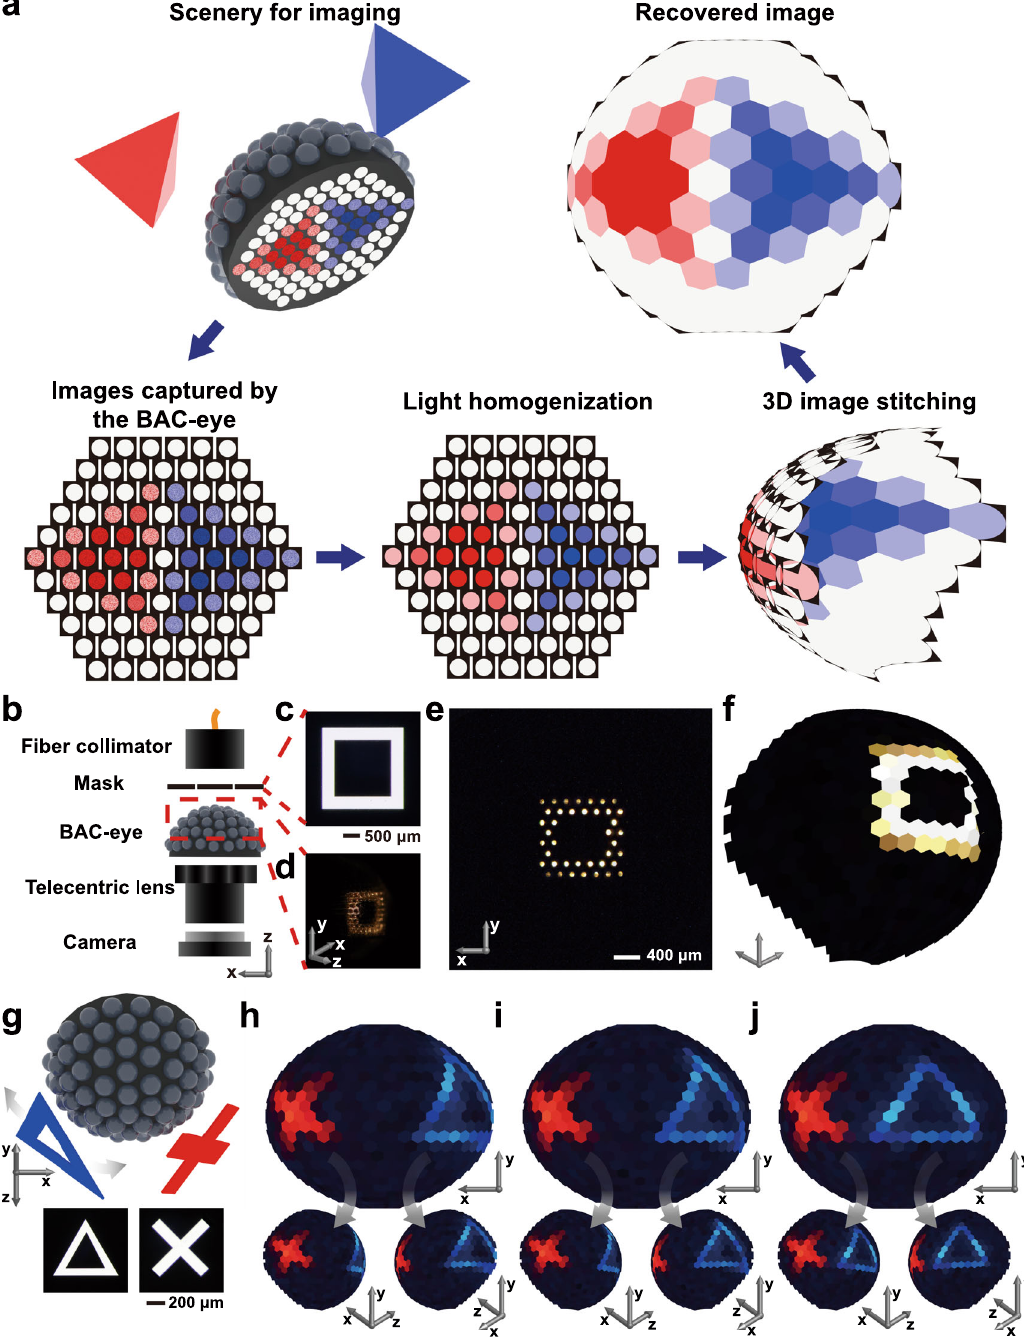
Fig. 4 Imaging using the BAC-eye. a Work fl ow for image acquisition and processing by the BAC-eye. The colour scale represents the intensity level of the detected signals. b Schematic diagram of the experimental setup of the imaging system. c The square mask used for image detection experiments. d The illuminated square pattern as detected by the BAC-eye. The image of the illuminated pattern on the arti fi cial ommatidia is captured by a single-lens re fl ex (SLR) camera equipped with a macro lens. e The square pattern image captured from the bottom of BAC-eye. f The digitally reconstructed hemispherical image. g Illustration of the hemispherical imaging for a red cross pattern whose centre is fi xed at an angular position of ( α = 60°, β = 0°) and a blue triangular pattern moving from the side ( α = 85°, β = 180°) toward the red cross. h – j The reconstructed images showing the triangle as it travels from ( α = 60°, β = 180°), ( α = 40°, β = 180°), and ( α = 20°, β = 180°). The digitally generated callouts provide stereoscopic vision (for a human observer) of the hemispherical α = 60° and β = 0° (the centre position of the cross), while a blue ( α = 40°, β = 180°) (Fig. 4i), and ( α = 20°, β = 180°) (Fig. 4j) are triangle with a line width of 200 μ m was moved from the side reconstructed. The patterns are clearly recognized and the toward the red cross. The corresponding panoramic views for the triangle at different angular positions is imaged with a high centre position of the blue triangle at ( α = 60°, β = 180°) (Fig. 4h), uniformity in size and shape. The image detected by the CMOS